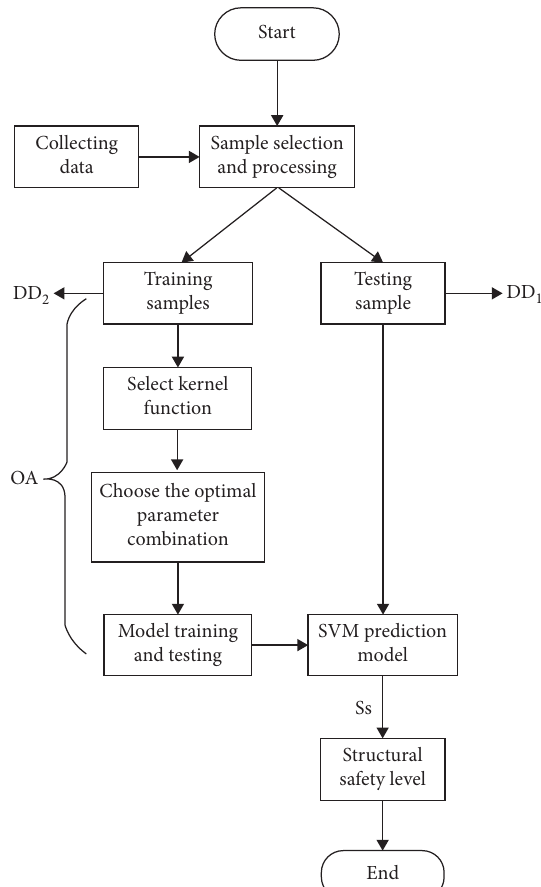
Figure 3: Digital twin and SVM-based security evaluation model.